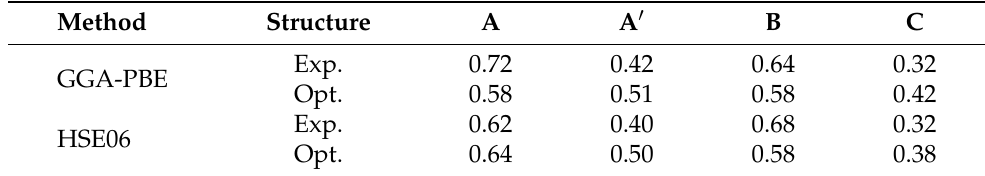
Figure 4. The LDOS in the low-temperature CO phase for the four molecules in the unit cell A, A (cid:48) , B, and C. ( a ) The LDOS calculated with HSE06 for the experimental structure and ( b ) for the geometrically optimized structure. ( c ) The LDOS calculated with GGA-PBE for the experimental structure and ( d ) for the geometrically optimized structure. The plotted LDOS contains four parts: the red, green, blue, and orange curves indicate that of A, A (cid:48) , B, and C, respectively. The dotted lines at 0 eV show the top of the valence bands. Table 2. The valence of the four molecules in the unit cell, i.e., the hole density obtained by integrating the LDOS shown in Figure